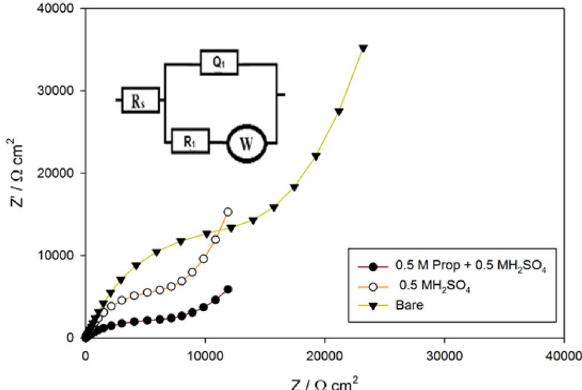
Figure 4. Nyquist plots of bare CPE in 0.5 M H 2 SO 4 and SMWZCPE in 0.5 M H 2 SO 4 with and without 0.5 M propylene glycol. (Inset: Fitting model (simple Randles model)).